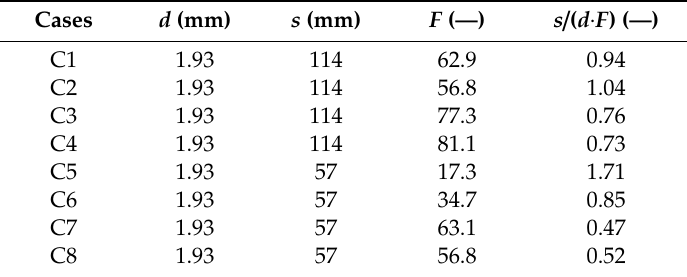
Table 1. Parameters of the simulated